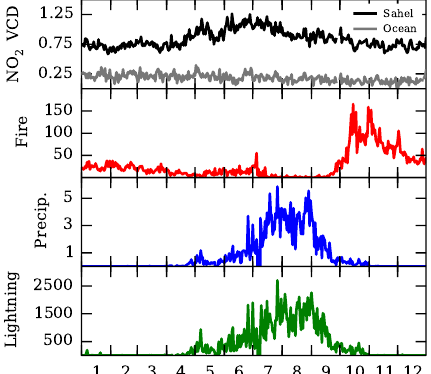
◦ W, 12– Figure 7. Daily time series for the Sahel region (0–30 18 ◦ N) averaged for the years 2007, 2008, 2009 and 2010. The first row of each panel shows mean NO 2 VCDs from OMI in moleculescm − 2 (black) and a clean ocean reference (grey, 130– 150 ◦ W, 12–18 ◦ N). The second row shows the number of active fire counts in the Sahel from MODIS. The third row shows average precipitation from the TMPA/TRMM product in mm. The fourth row shows the number of lightning strikes detected by